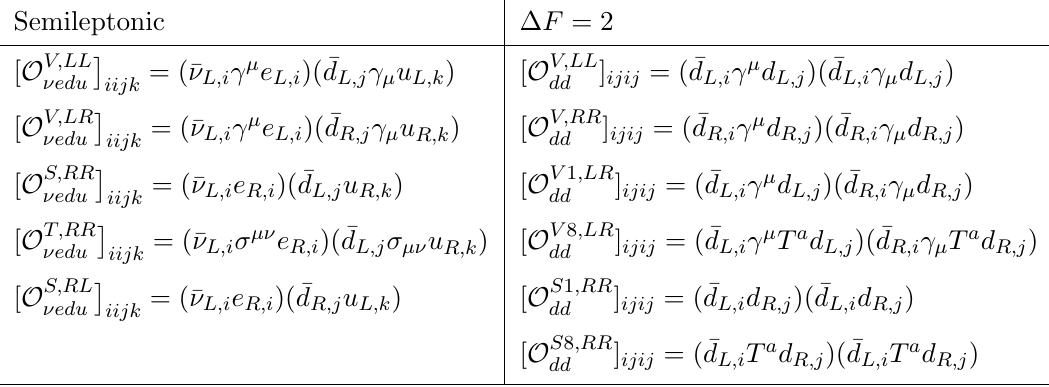
Table 1 . Operators in the LEFT [22] relevant for semileptonic charged-current transitions and B d;s